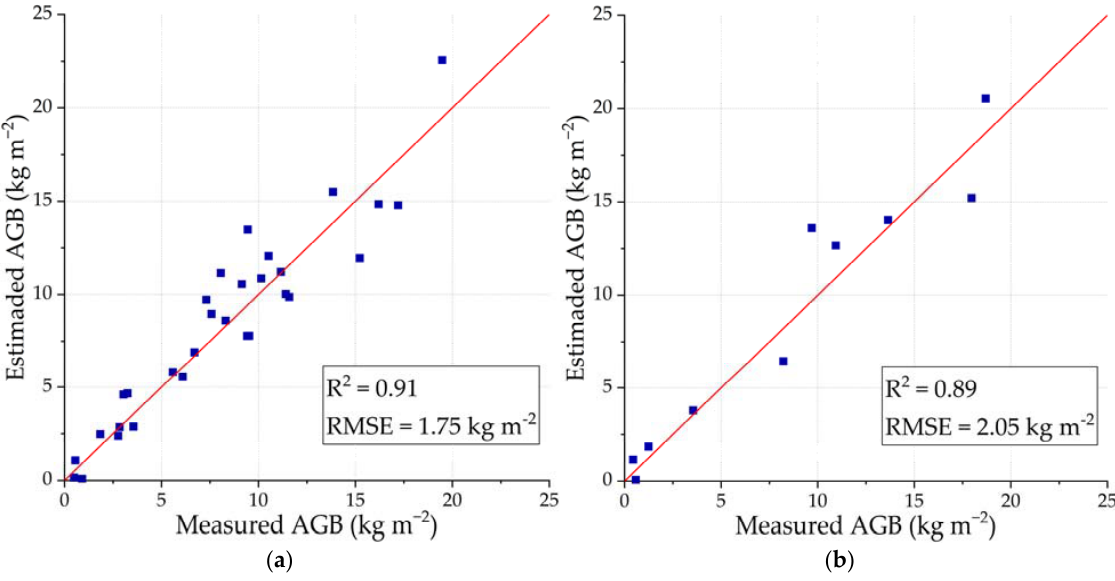
Figure 11. Estimated AGB vs. measured AGB of the experimental area. ( a ) Training dataset. ( b ) Validation dataset.